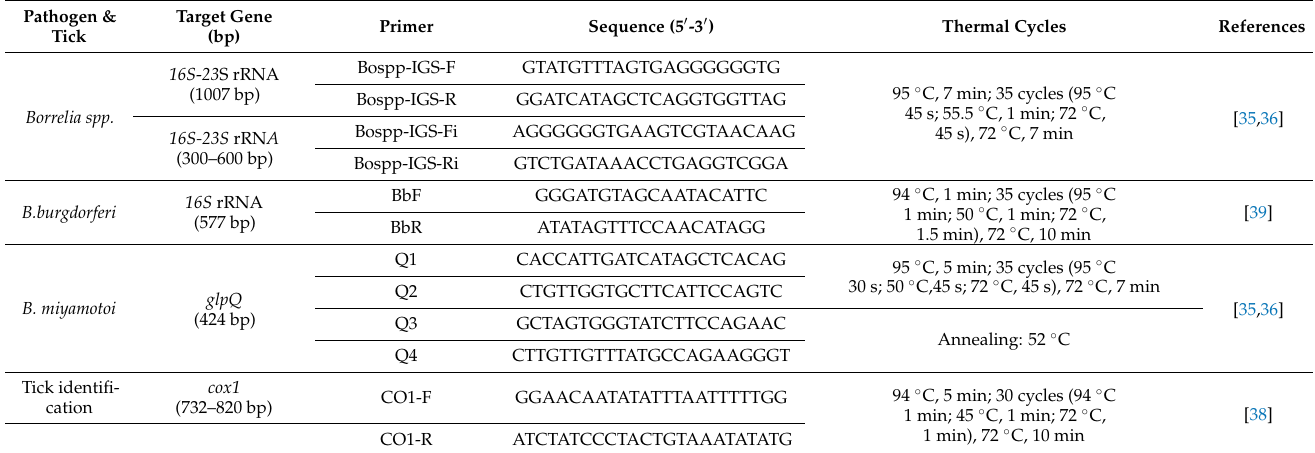
Table 1. Primer sequences used in this study and PCR amplification